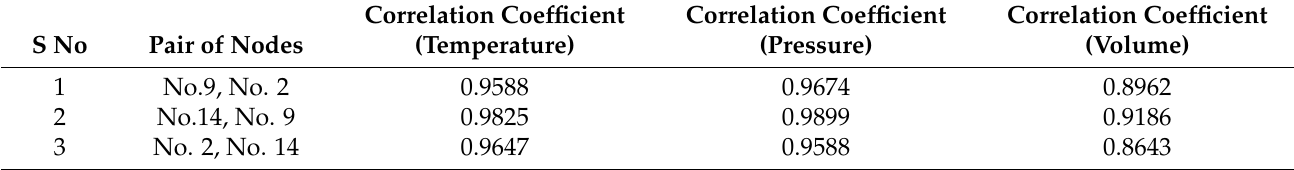
Table 3. Correlation coefficient between nodes.